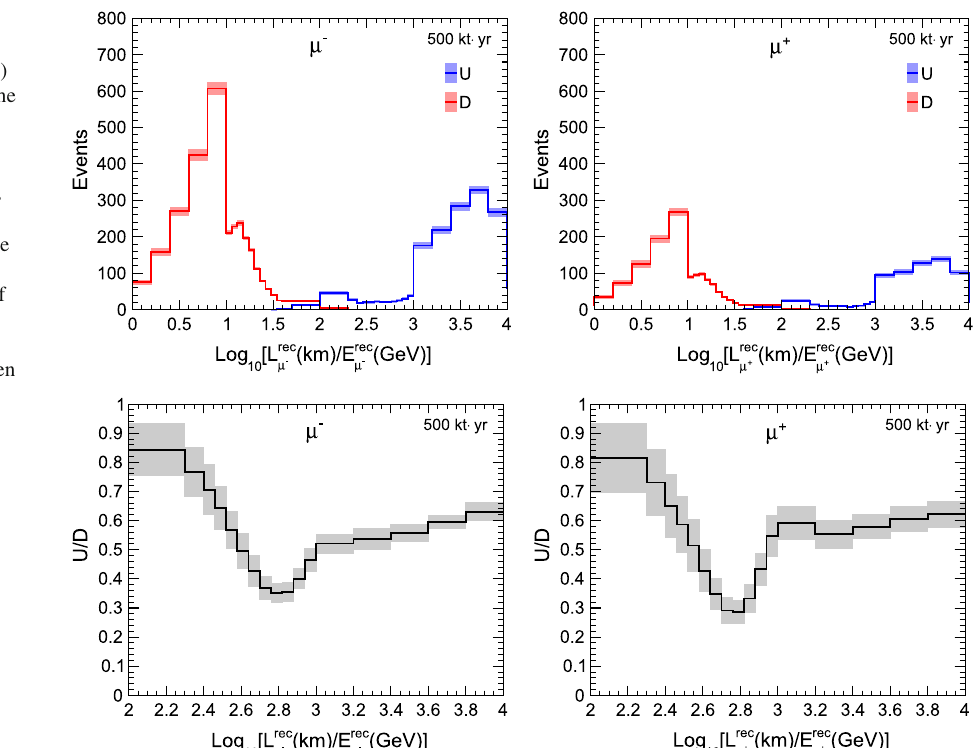
Fig. 4 Upper panels: the expected log 10 [ L rec μ / E rec μ ] distributions for μ − (left panel) and μ + (right panel) events. The red and blue lines are for downward-going and upward-going events, respectively. The shaded boxes represent statistical uncertainties. Lower panels: the U/D ratios as functions of log 10 [ L rec μ / E rec μ ] . The height of shaded boxes represents expected uncertainties in the U/D ratio. The exposure is taken to be 10 years of 50 kt ICAL, i.e. 500 kt · yr. We use the oscillation parameters given in Table